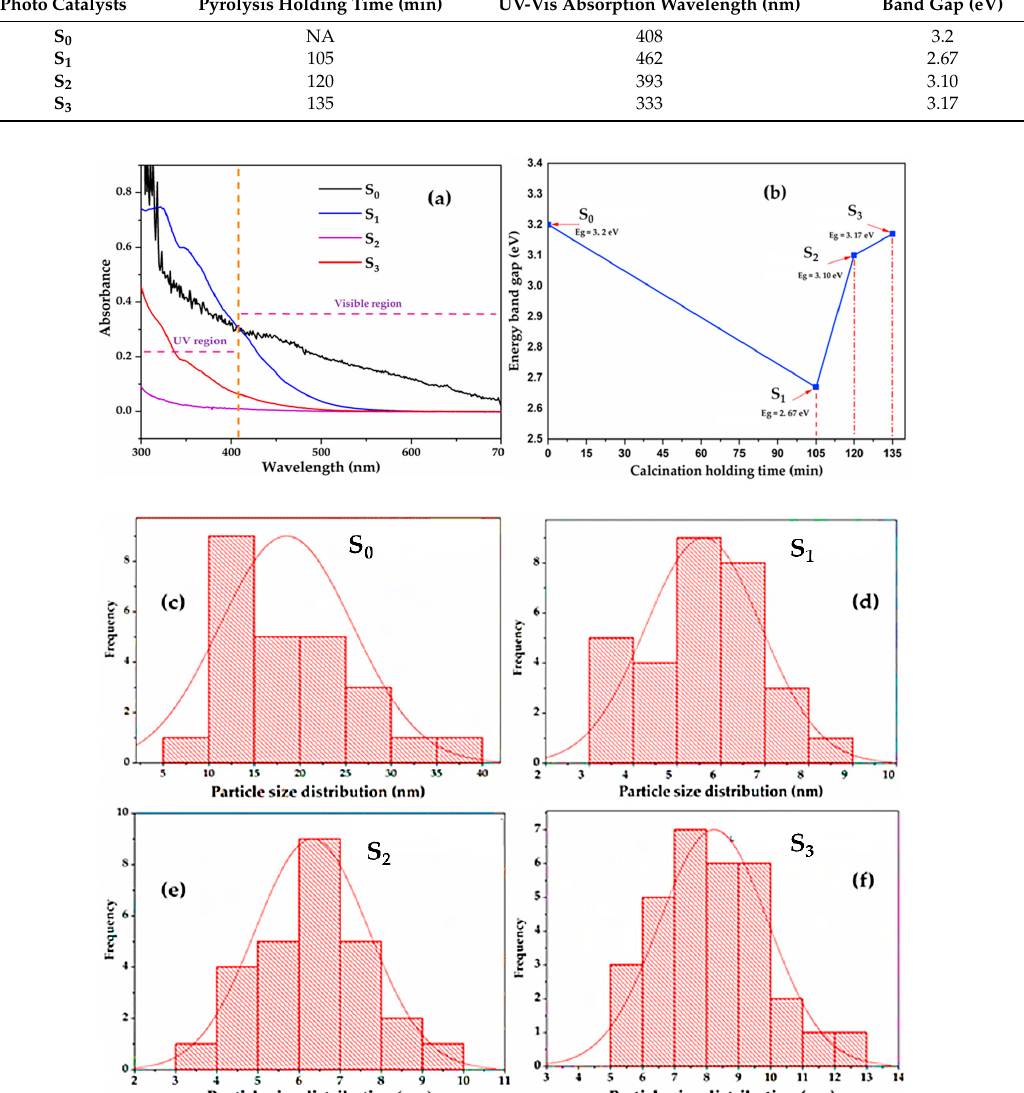
Figure 7. E ff ect of calcination holding time (min) on band gap ( a , b ) and particle distribution of the Degussa TiO 2 ( c ) compared to the synthesised C–N–TiO 2 nano composites pyrolysed at 350 ◦ C for 105 ( d ); 120 ( e ) and135 ( f ) minutes (S 0 = with Degussa TiO 2; S 1 = C–N–TiO 2 105 min; S 2 = C–N–TiO 2 120 min and S 3 = C–N–TiO 2 135